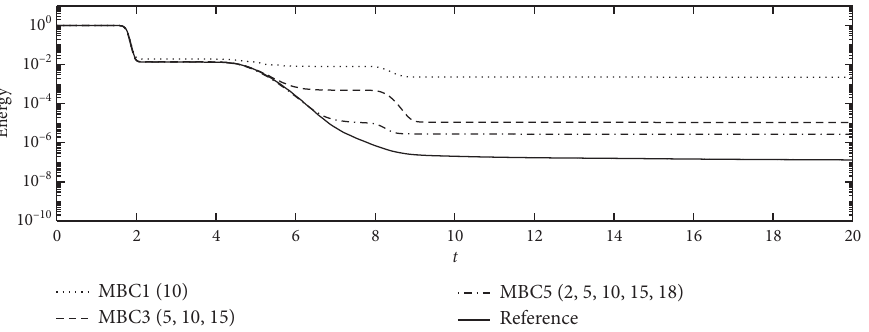
Figure 13: Energy of the wave packet with two major wave numbers k � 4 and